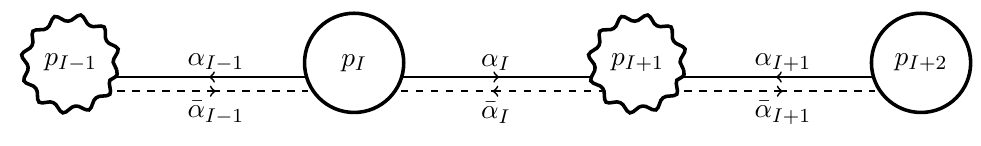
Figure 8 . A quiver diagram for a 4-node 1/8 BPS